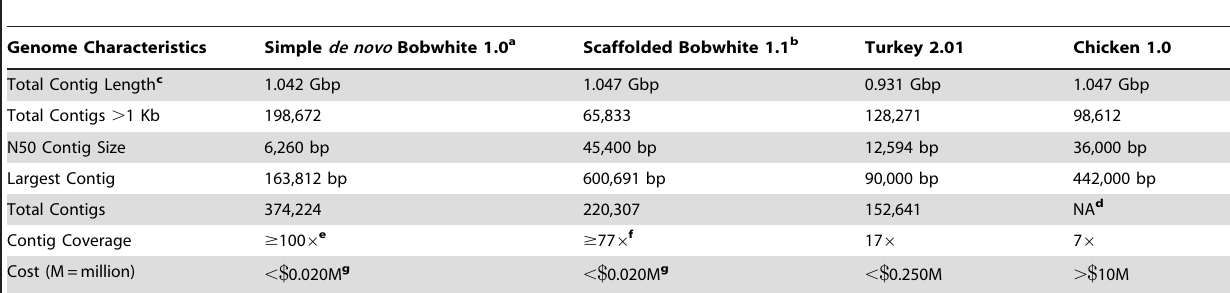
Table 2. Summary data for the bobwhite de novo genome assembly with comparison to the initial turkey and chicken genome